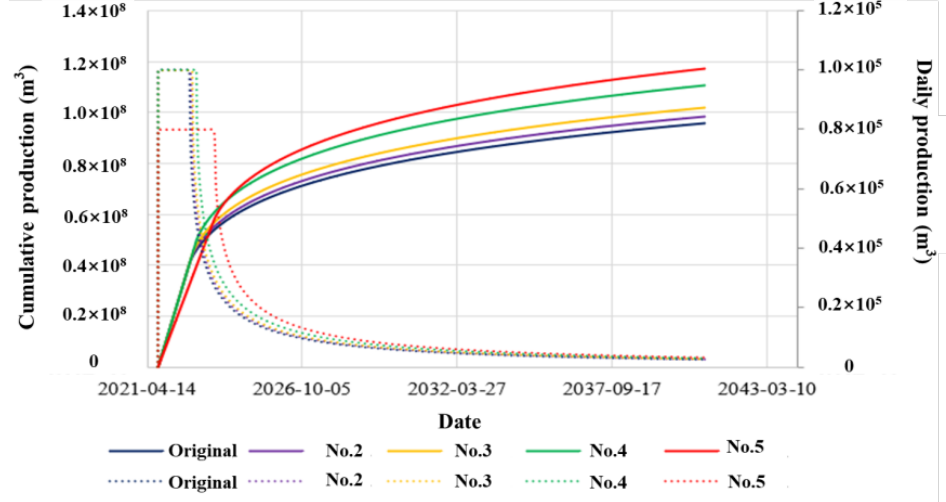
Table 4. The increase in EUR under different strategies.